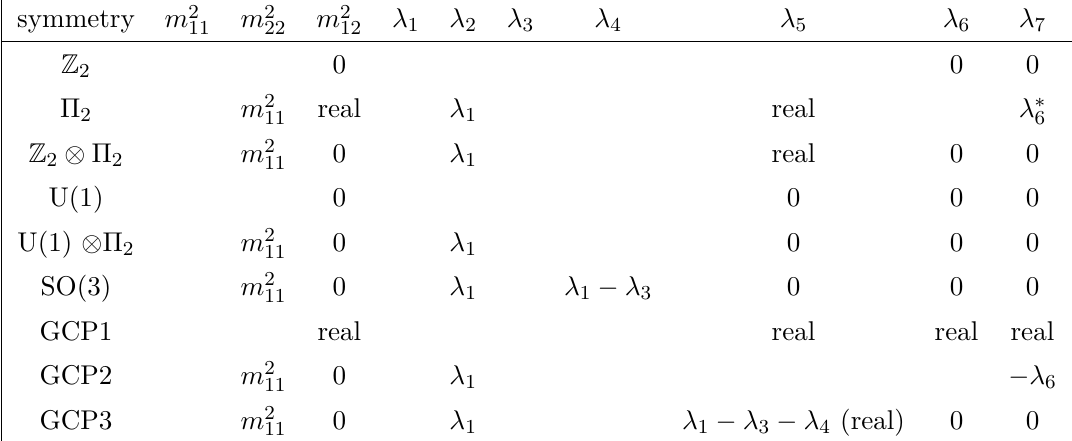
Table 3. Classification of 2HDM scalar potential symmetries and their impact on the coefficients of the scalar potential [cf. eq. (2.1)] in a generic basis [22, 43–46]. Empty entries in table 3